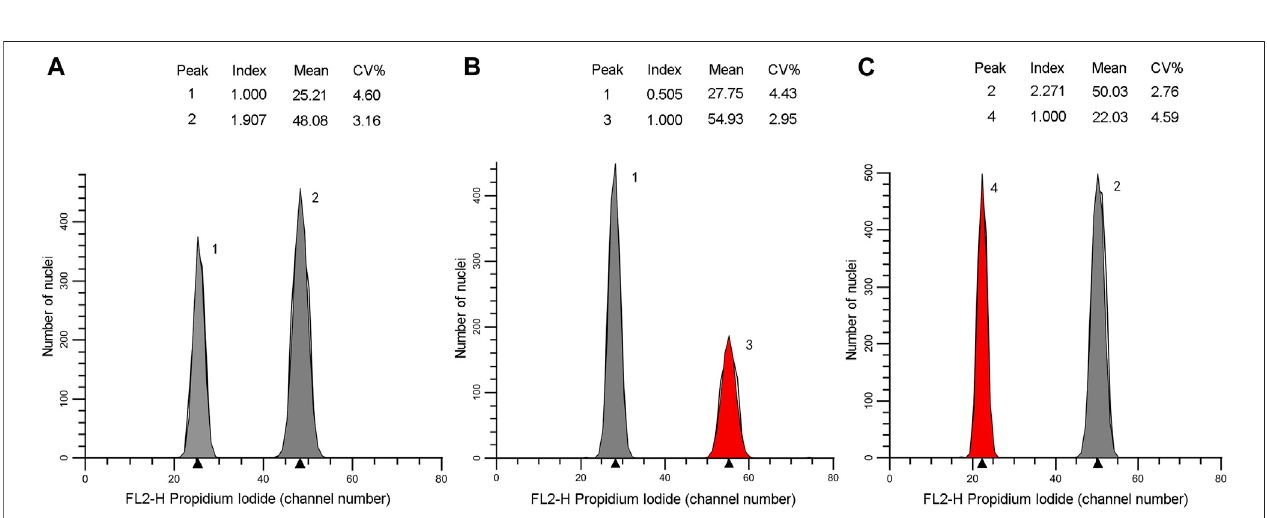
FIGURE6| Flowcytometric histogramsoftheindividualsN3-8 (A,B) and S1-2 (A,C) . Xanthocyparisvietnamensis (peak1and2),standardI: Pseudolarixamabilis (peak 3), standard II: Cupressus funebris (peak 4).